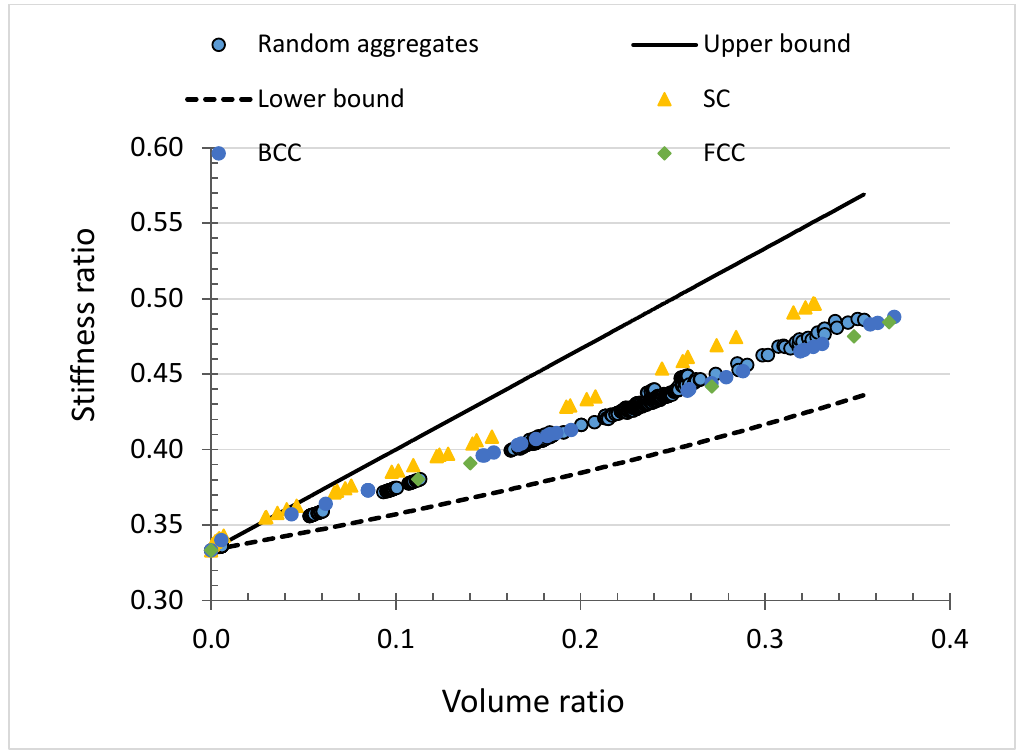
Fig. 12. Stiffness of uniform spherical stones aggregates versus those of random stones